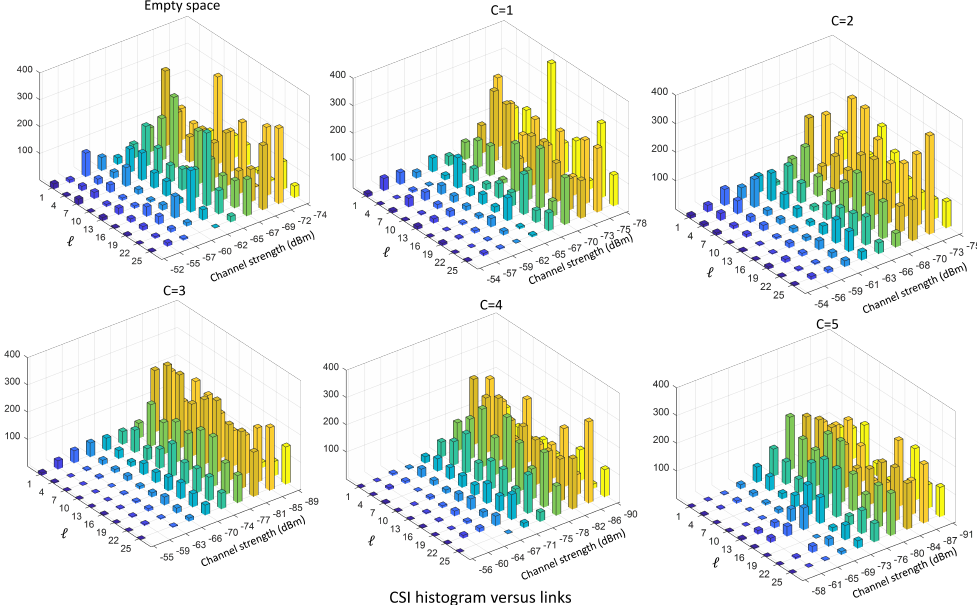
Figure 3. CSI histograms versus links p (cid:96) ( s ) with (cid:96) = 1, . . . ,27, for the number of people ranging from C = 0 (empty environment) up to C = 5 evaluated by aggregating data over K = 30